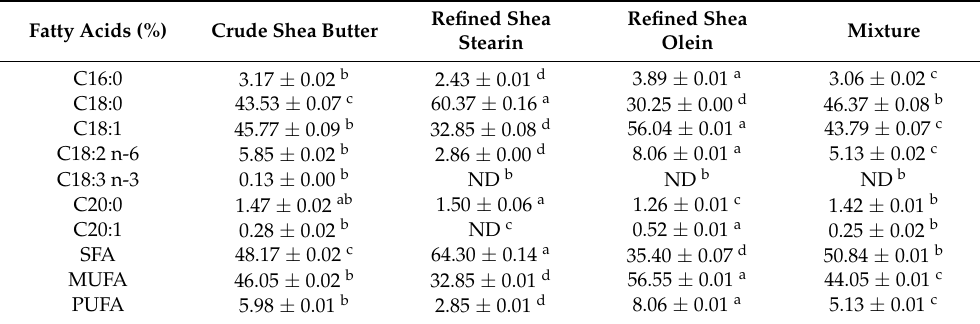
Table 1. The fatty acid composition (%) of crude shea butter, refined shea stearin, refined shea olein and a mixture of olein:stearin (1:1 w / w